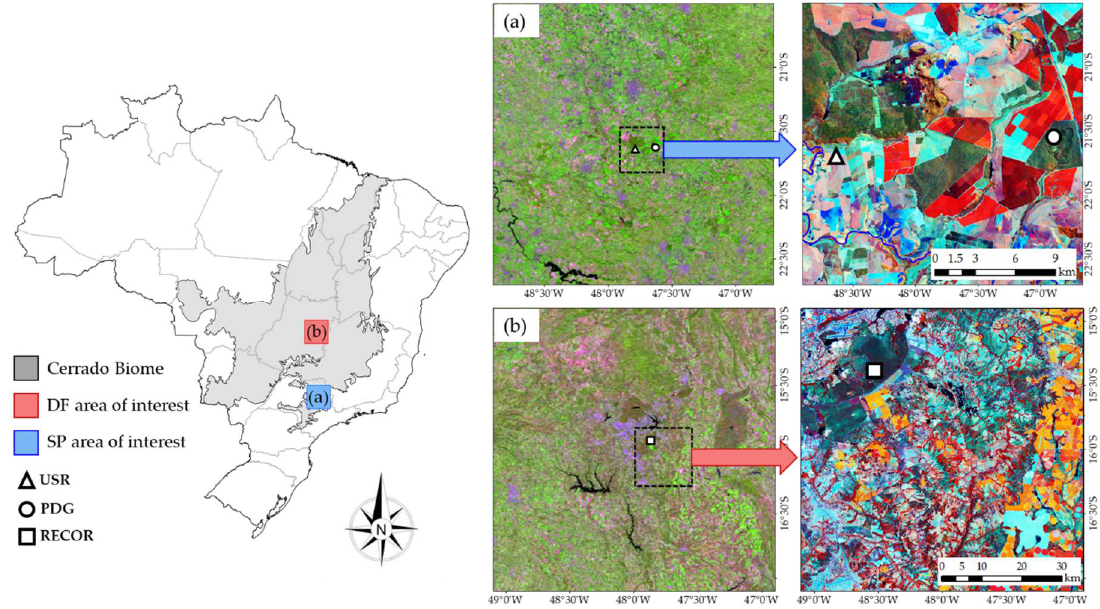
Figure 1. Study Area in the Brazilian Cerrado—( a ) São Paulo area of interest and ( b ) Federal District area of interest—Color composites from MOD09GA ( left ), OLI/Landsat-8 (5 January 2014 ) for Brasília study area ( upper right ) and TM/Landsat-5 (14 April 2016) for São Paulo study area ( bottom right ). The flux tower sites are indicated on the map.